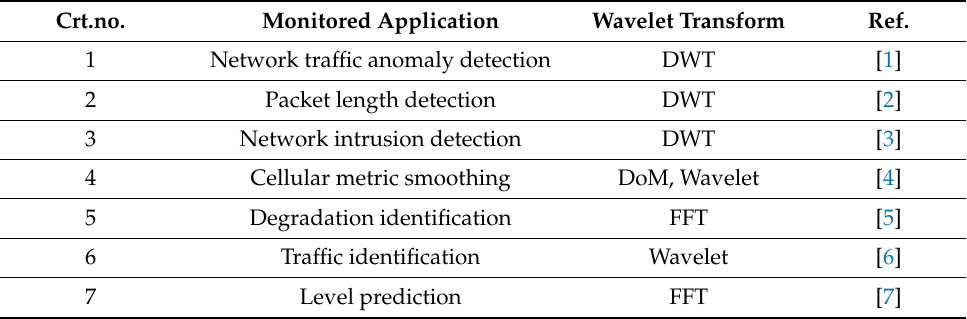
Table 1. Applications of the wavelet transform for the analysis of traffic in the communications networks. Crt.no. Monitored Application Wavelet Transform